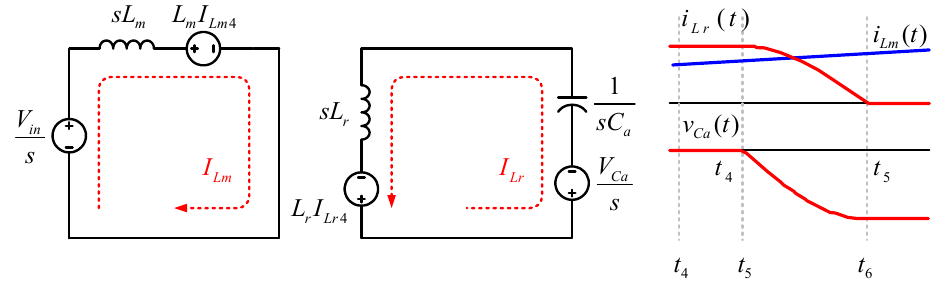
Figure 8. The equivalent circuit of Mode 5 and key waveform.